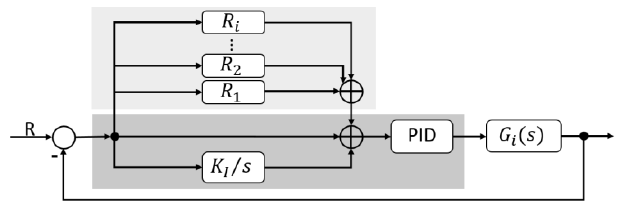
Figure 7. Control loop for the VCM actuated FTS system.